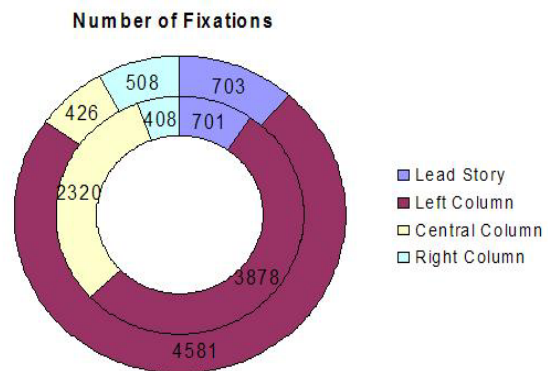
Figure 5 - Ring diagram that compares number of fixations within AOIs in the two Case Study. Internal ring: Corriere della Sera, External ring: La